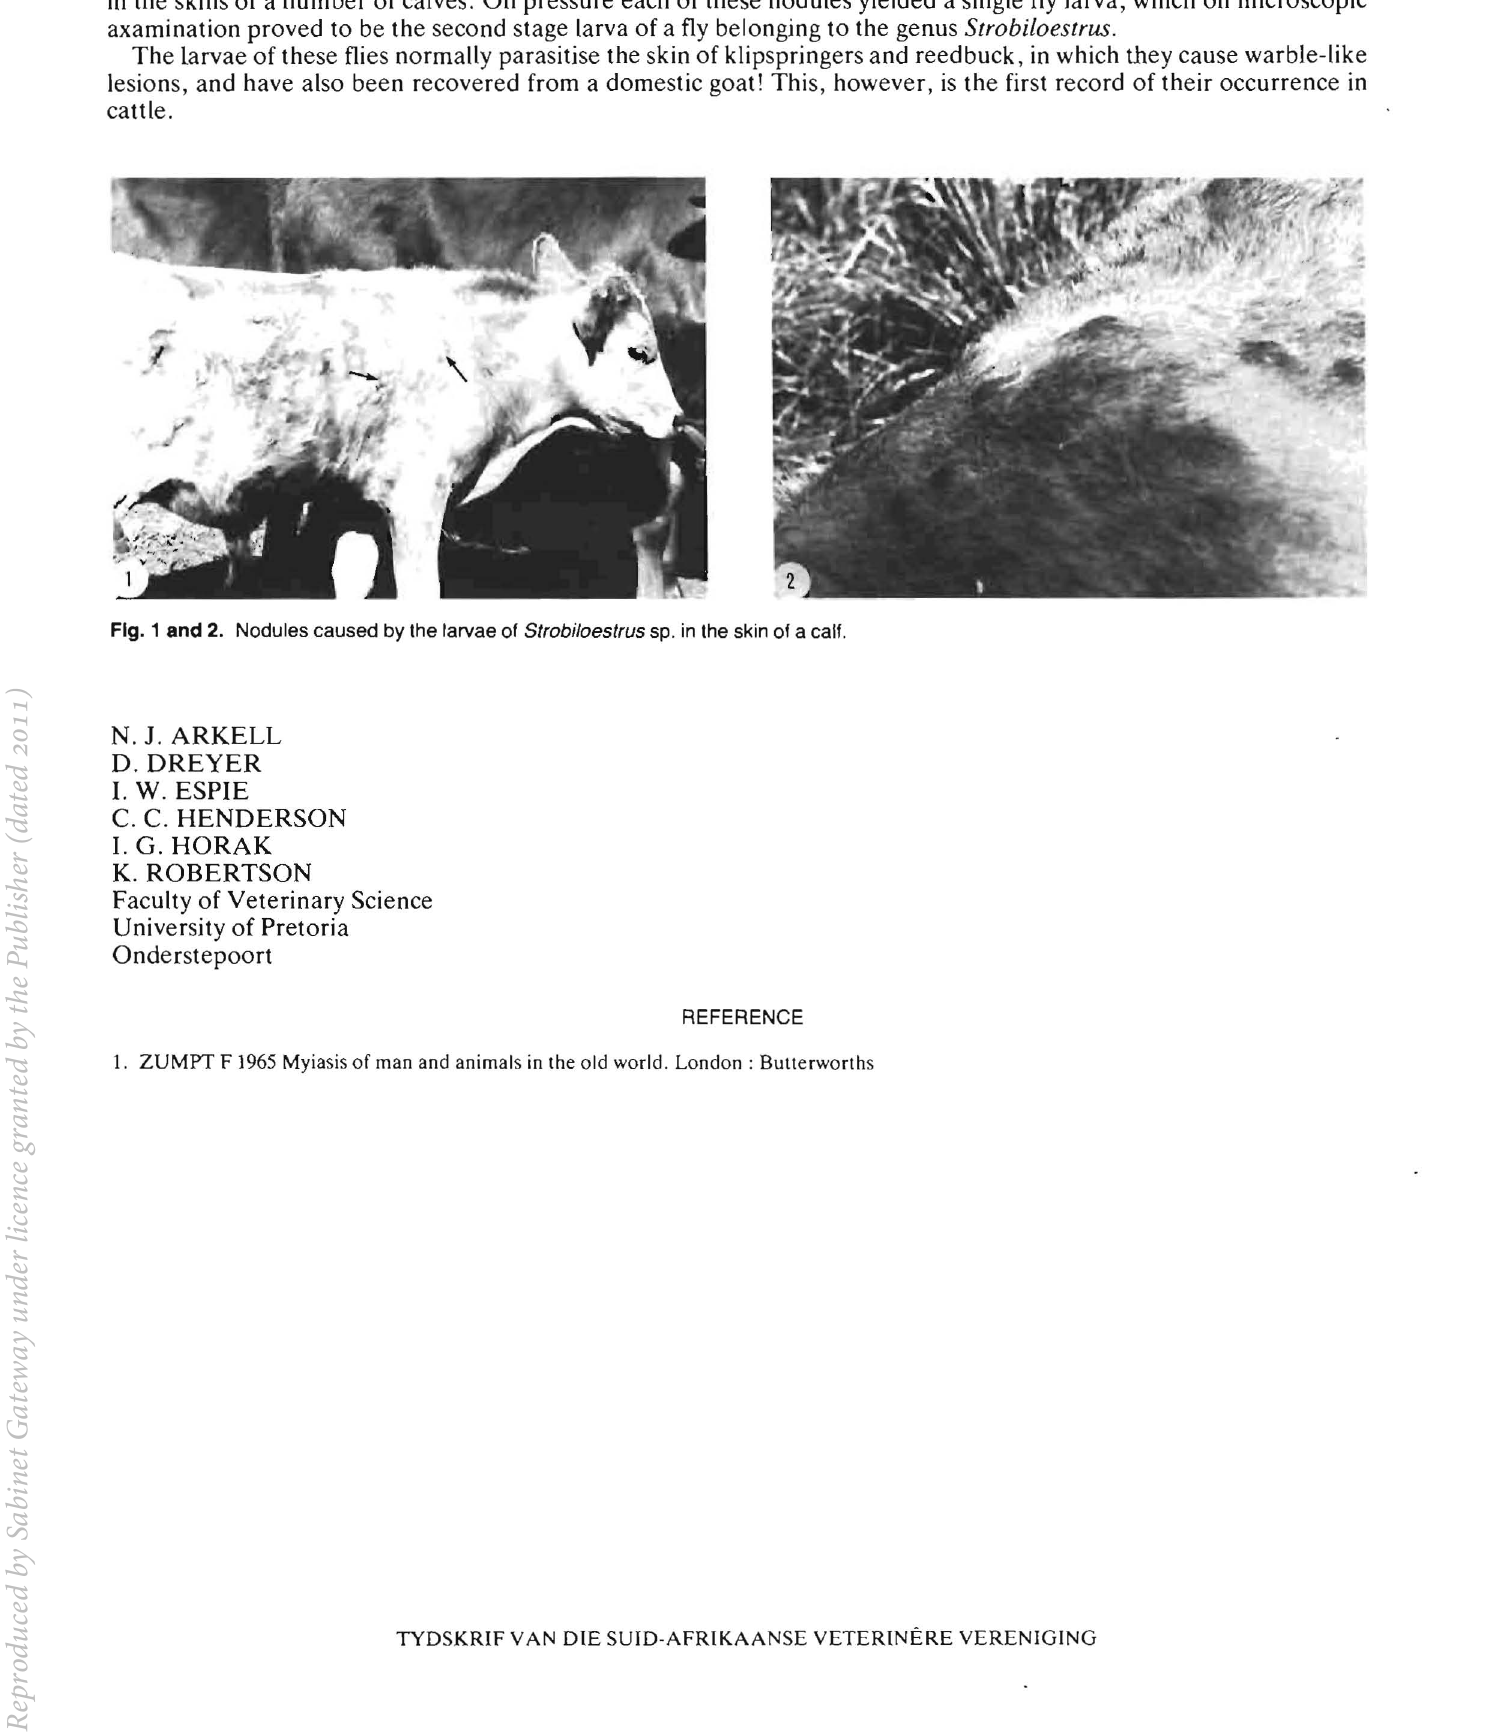
Fig. 1 and 2. Nodules caused by the larvae of Strobiloestrus sp. in the skin of a calf.